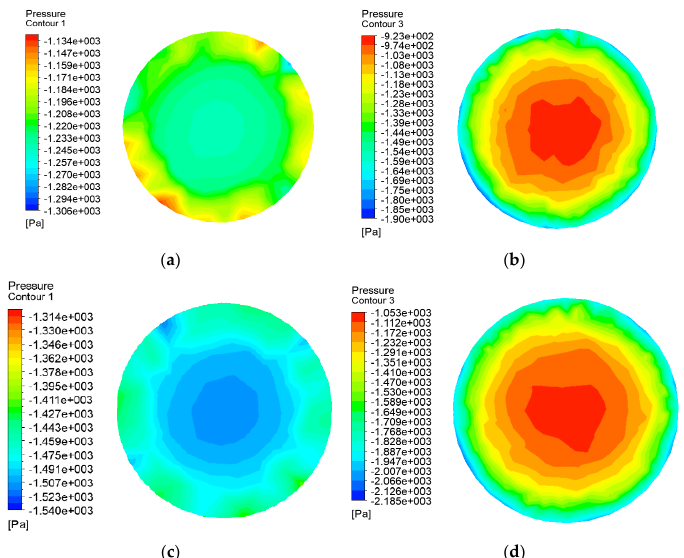
Figure 14. Suction end face pressure cloud. ( a ) Cylindrical-shaped suction hole; ( b ) Funnel-shaped suction hole; ( c ) Horn-shaped suction hole; ( d ) Diabolo-shaped suction